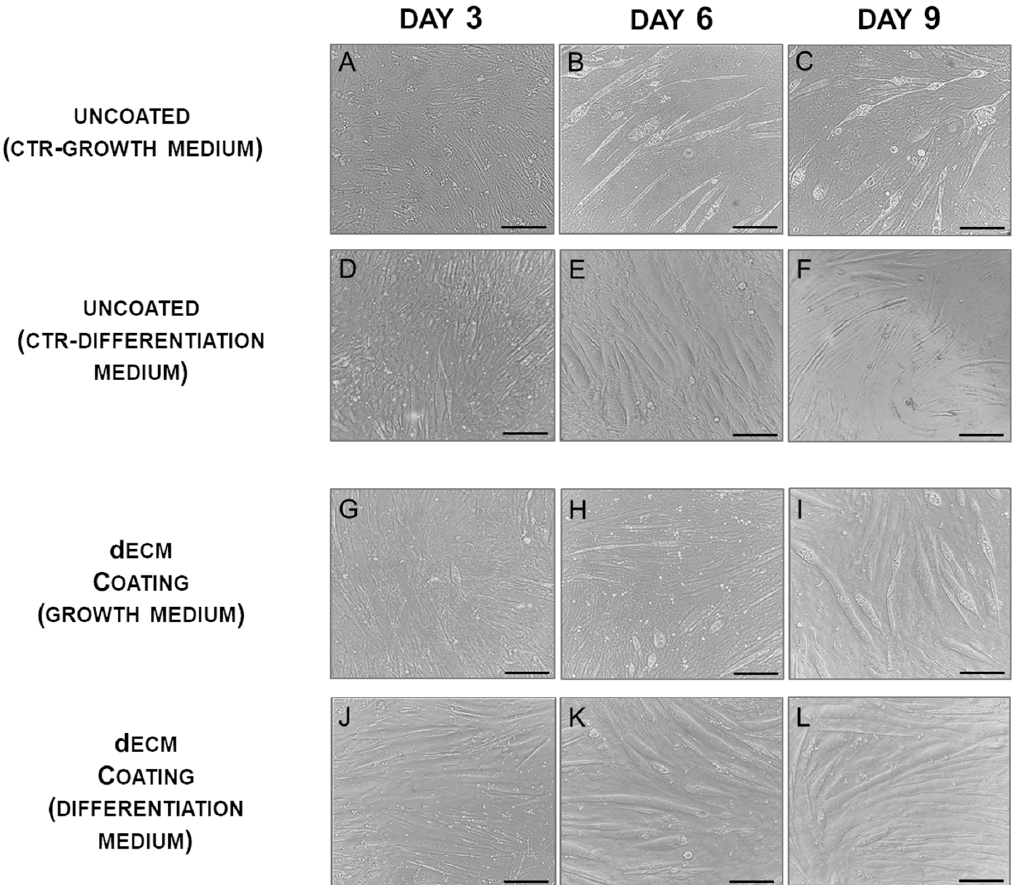
Figure 2. dECM enhances the differentiation of C2C12 myoblasts to myotubes. Cells were induced to differentiate in low serum medium in plates either uncoated (2 top rows) or coated (2 bottom rows) with dECM. Representative images of cultures at day 3 ( A , D , G , J ); at day 6 ( B , E , H , K ); at day 9 ( C , F , I , L ) post-differentiation. Scale bars: 100 µm.